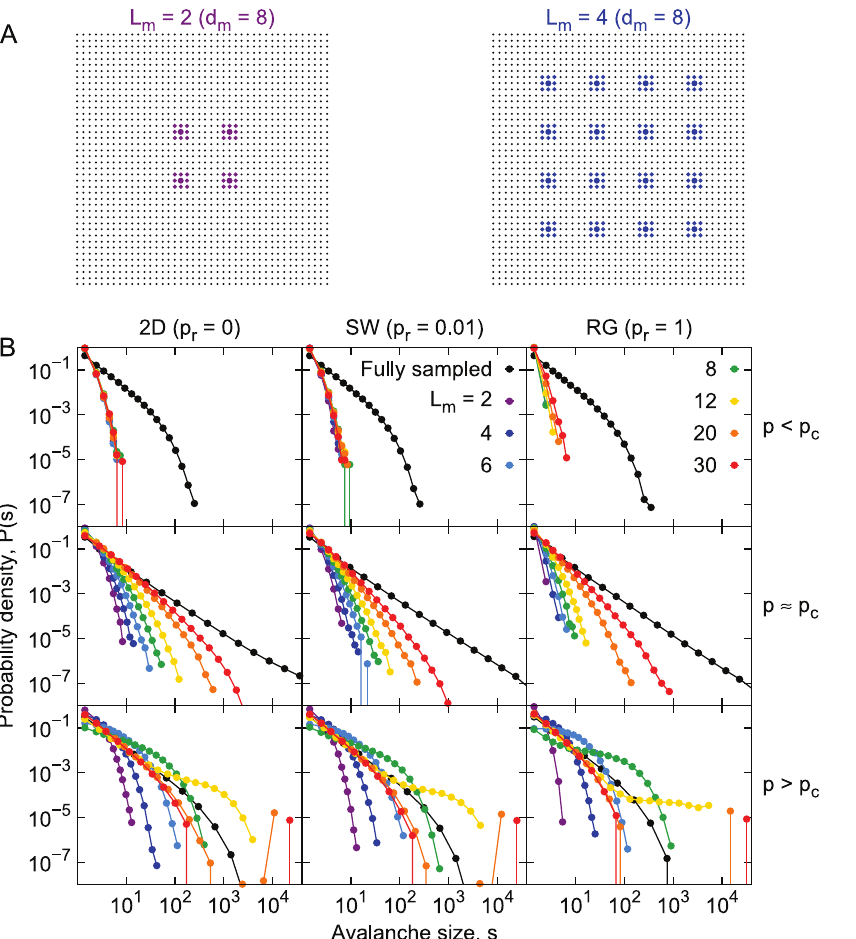
Figure 4. Undersampled size distributions: varying the number of sampled sites. A) Examples of the sampling matrix. Only the colored sites are considered for avalanche measuring. Colored circles indicate virtual electrodes center, with diamond indicating possible sampling sites (see Methods). B) Avalanche size distributions obtained from different underlying topologies (columns) and dynamical regimes (rows), while sampling the systems with a MEA-like configuration. Colors represent different sizes of the virtual sampling MEA (black for fully sampled